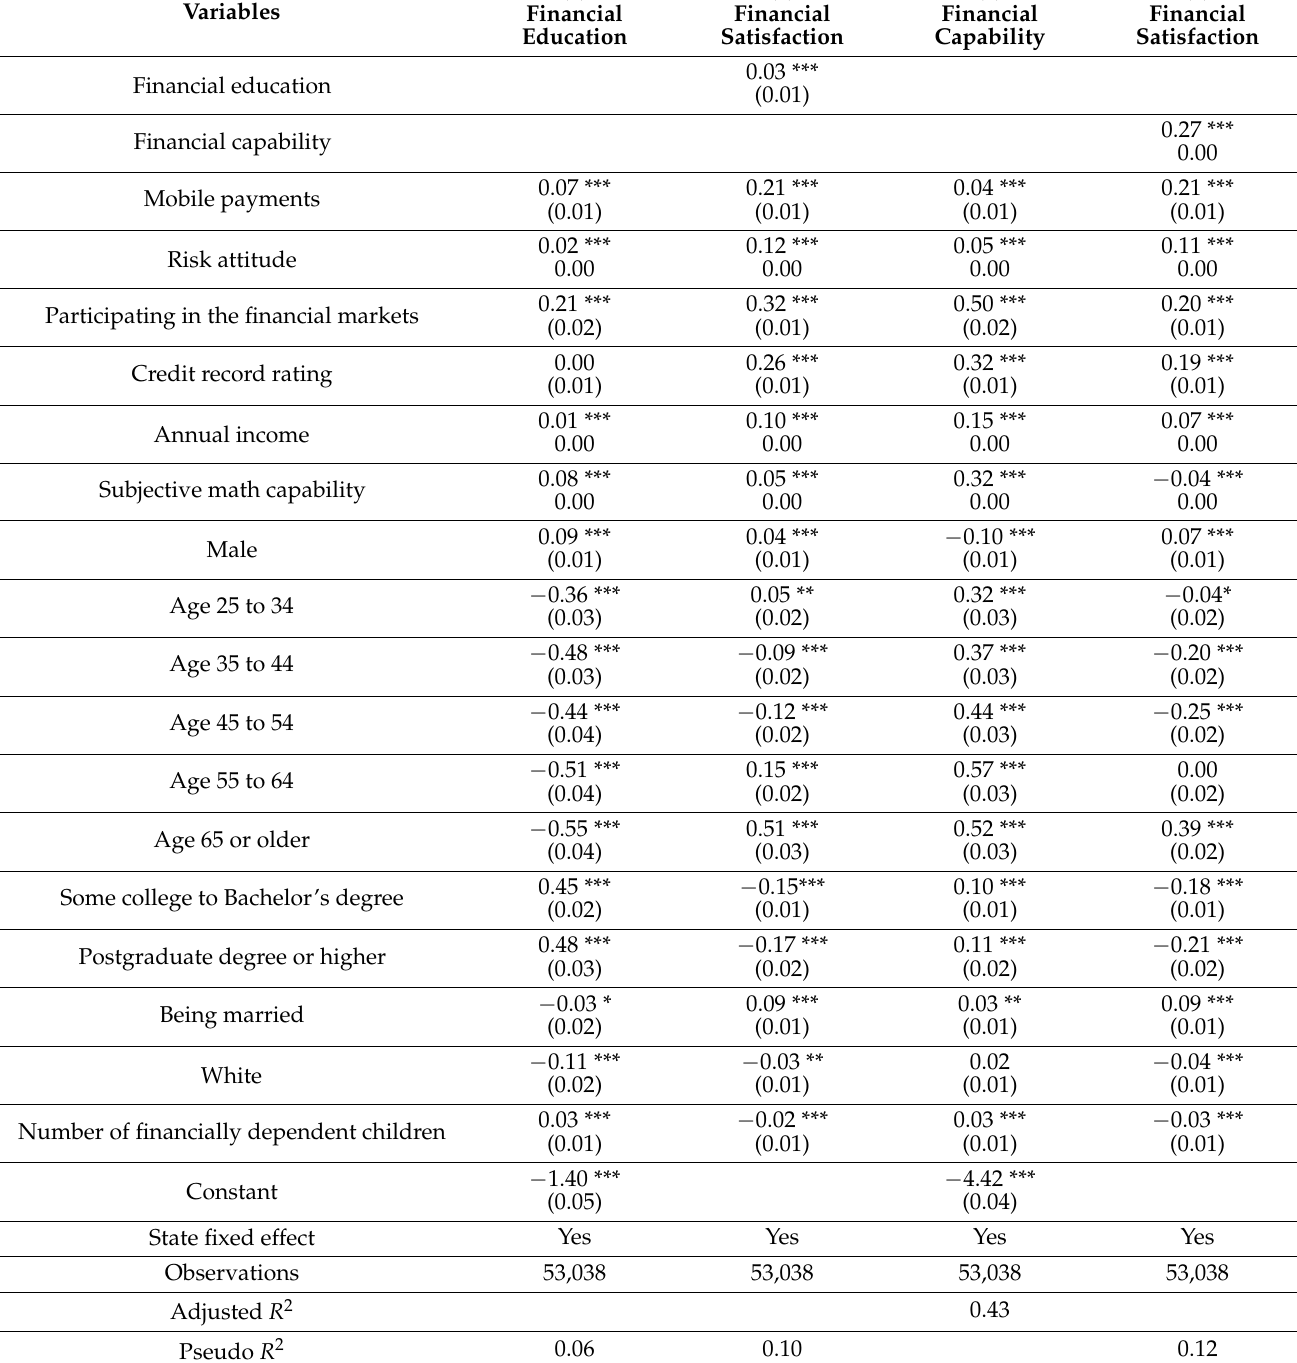
Table 6. Results of financial education and capability as